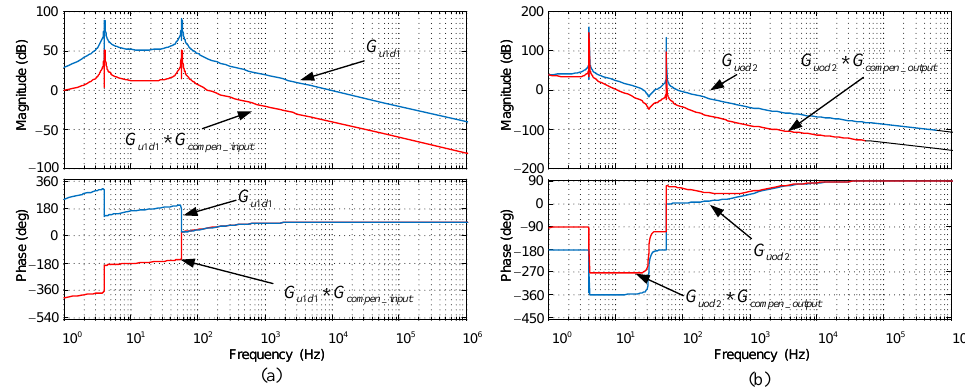
Figure 7. Bode diagrams of two transfer functions. ( a ) Input loop, ( b ) output voltage loop.